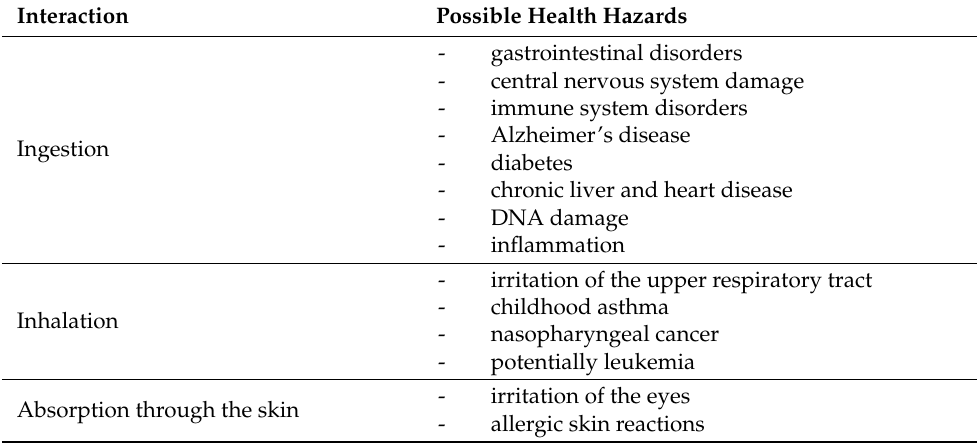
Table 1. Hazardous effects of formaldehyde